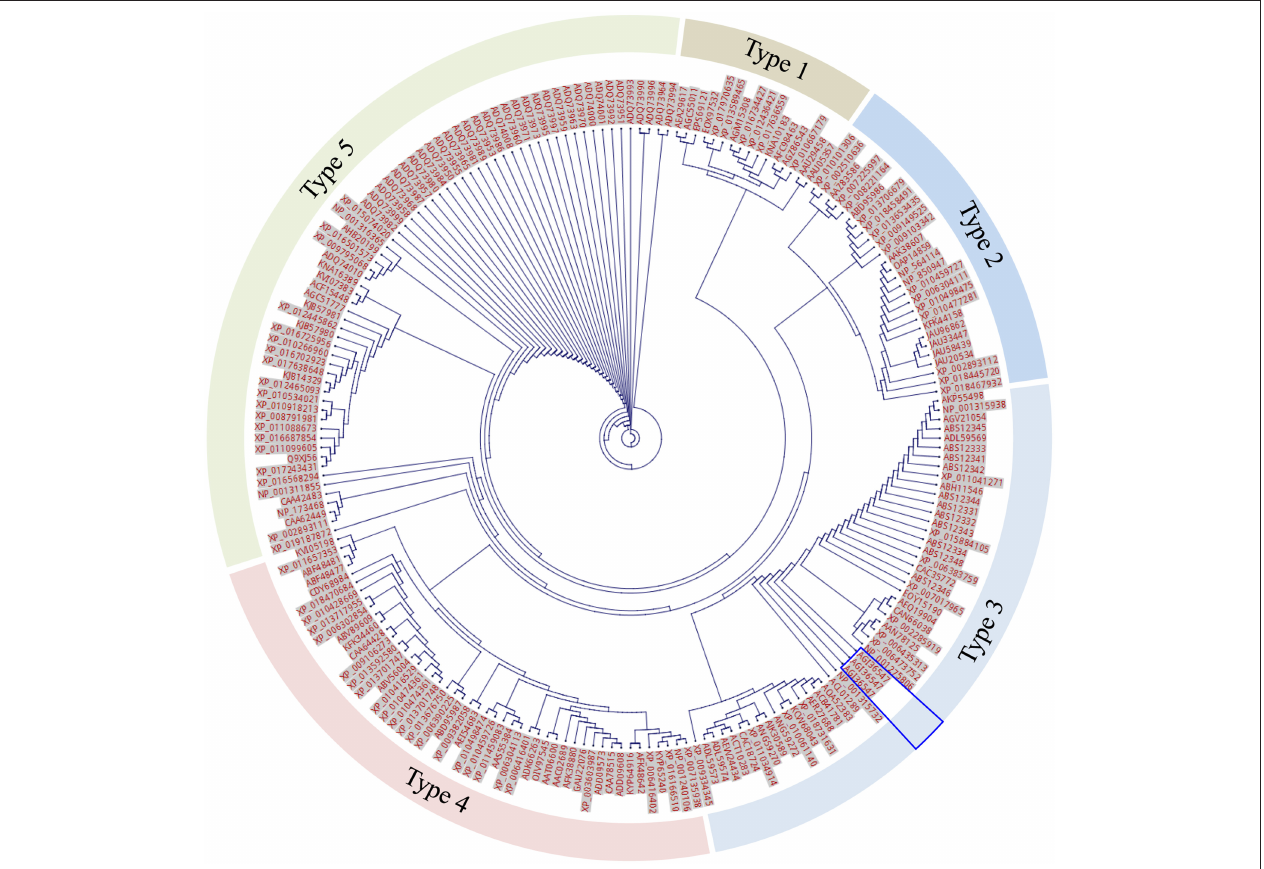
FIGURE 7 | Unrooted tree of total 208 expanded F-segment sequences using CLC Genomics Workbench. The labels beside each dot are protein NCBI accession numbers. The segments are arranged into 5 classes based on the genetic distance. The unique expanded F-segment (three copies from RcDhn 2) is highlighted by the blue box. All are